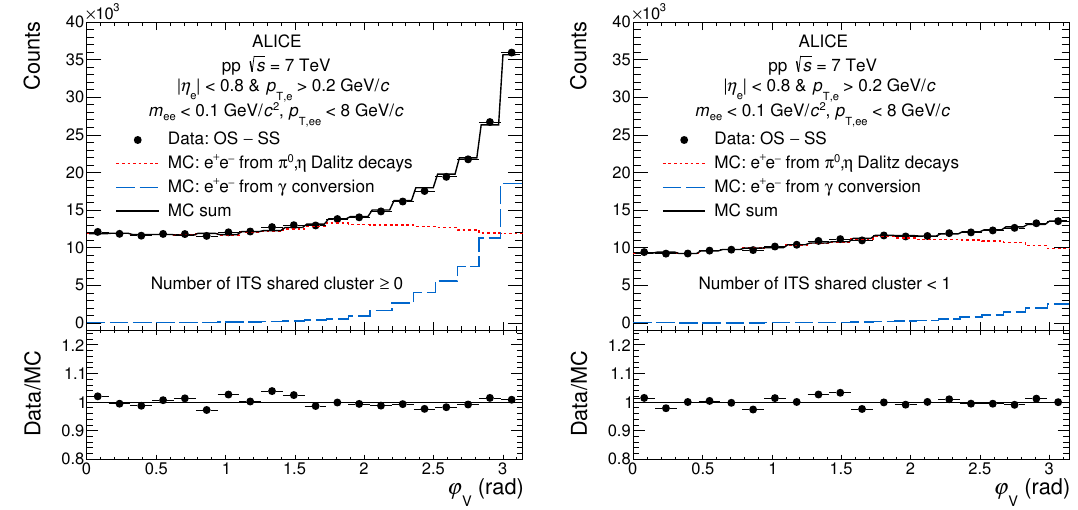
Figure 4 . Measured ’ v distribution of correlated e + e (cid:0) pairs with m ee < 0.1 GeV/ c 2 and p T ; ee < 8 GeV/ c compared with a sum of MC templates for di(cid:11)erent dielectron sources. The dis- tributions are shown for all tracks including those that share some ITS clusters with other tracks (left) and with such tracks removed (right), as in the analysis. Only statistical uncertainties are shown for the data points.